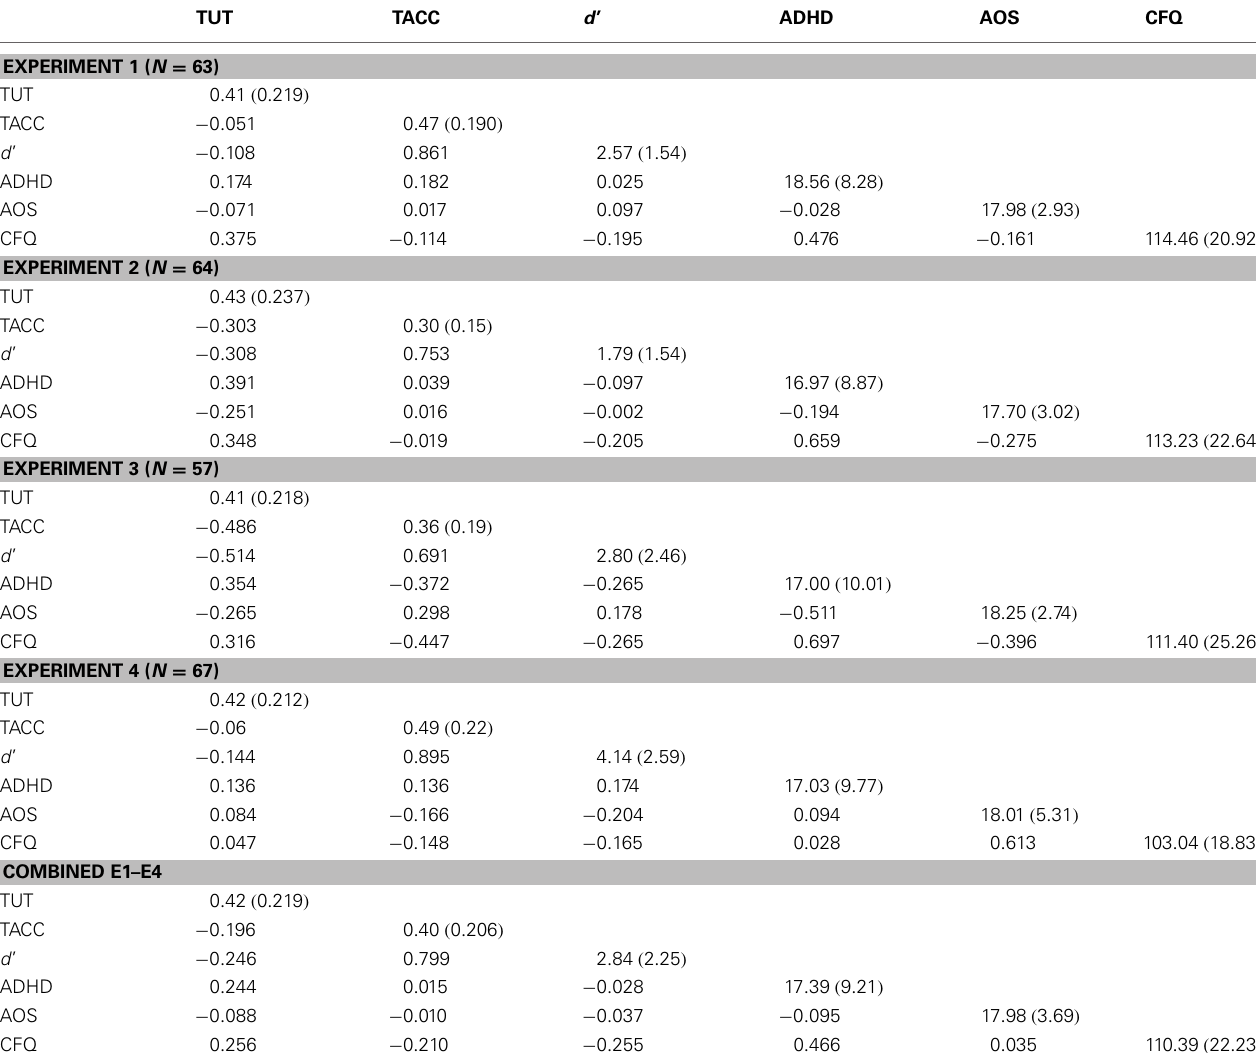
Table 1 | Correlations among questionnaire and SART (mind wandering and performance) measures in Experiments 1–4, individually and